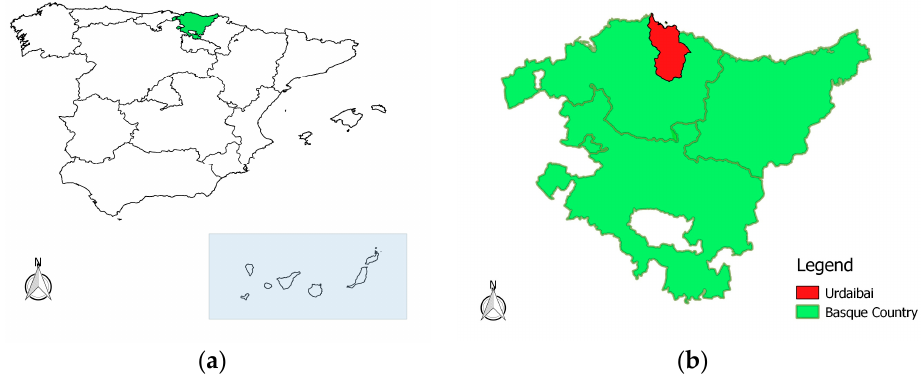
Figure 1. The landscape of Urdaibai. ( a ) Spain; ( b ) Urdaibai: Basque Country.